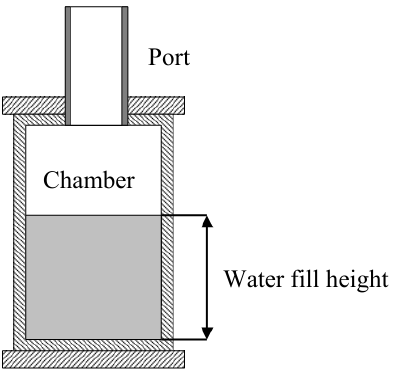
Figure 2. Water filling of resonant